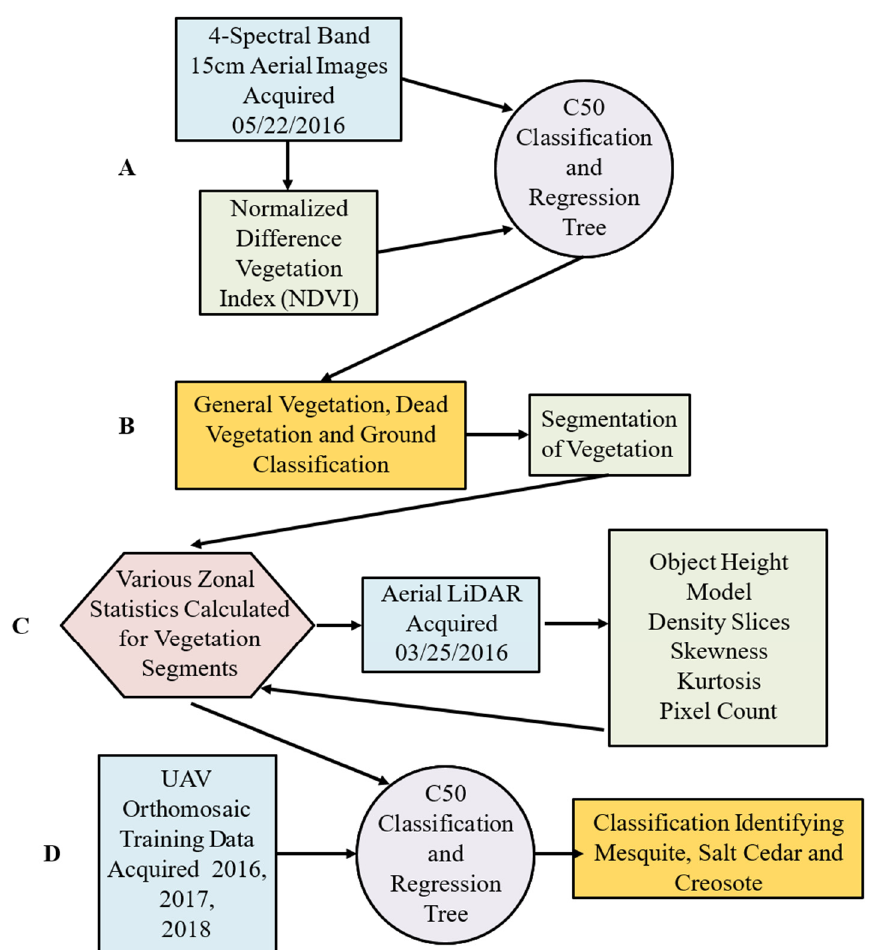
Figure 2. Workflow Diagram. ( A ) We performed a classification using the high-resolution multispectral imagery to identify vegetation, detritus, and bare ground in the study area. ( B ) We created segments representing vegetation by grouping conjoining vegetation pixels. ( C ) We extracted metrics derived from the photographs and LIDAR data for each vegetation segment. ( D ) Using the C50 algorithm, we identified the species type of each segment.